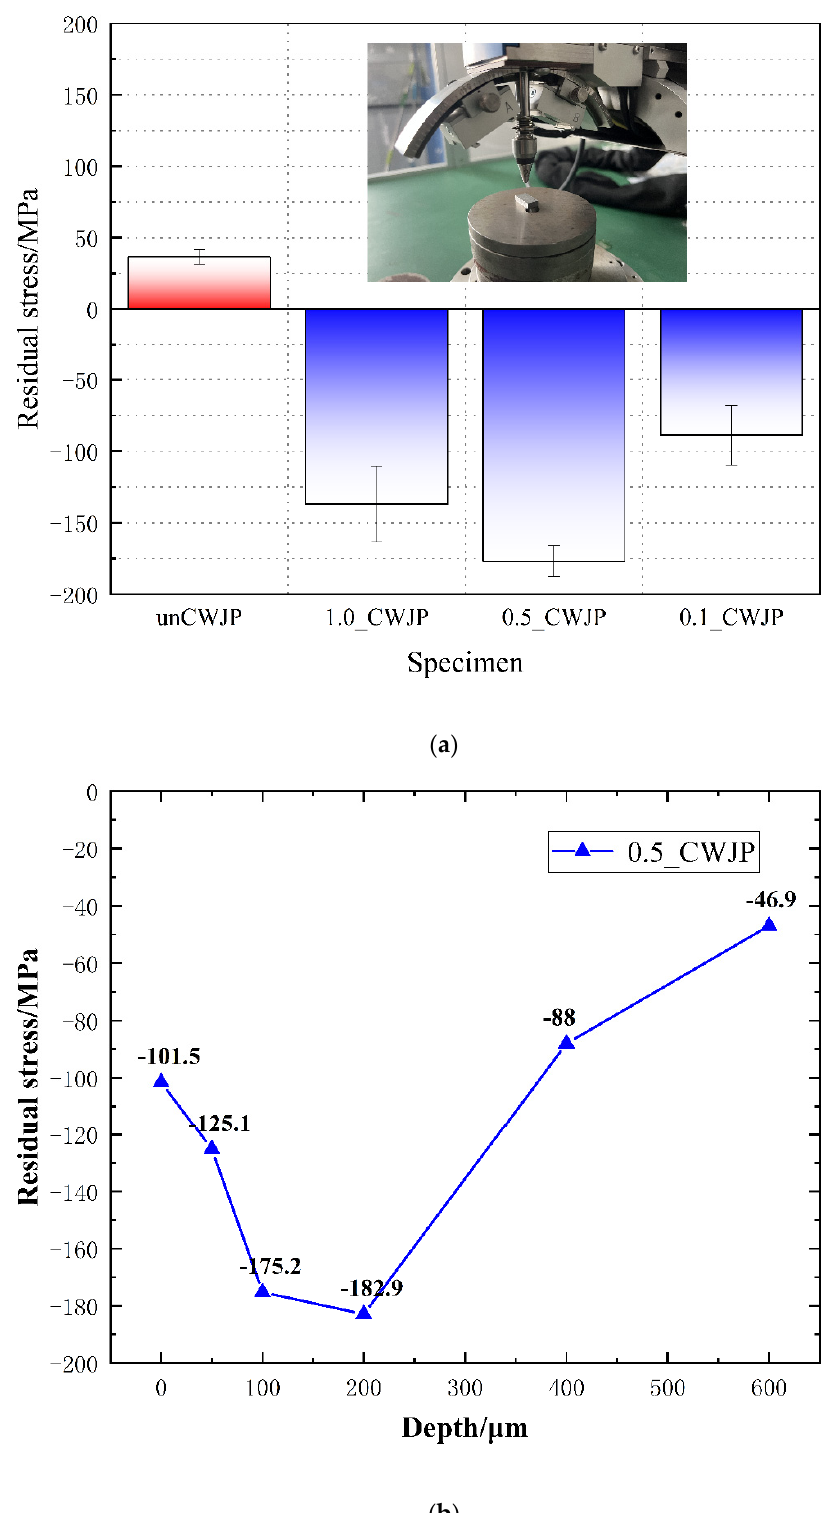
Figure 5. Residual stress. ( a ) Surface residual stress before and after CWJP. ( b ) Residual stress distribution curve of the 0.5_CWJP specimens in depth.